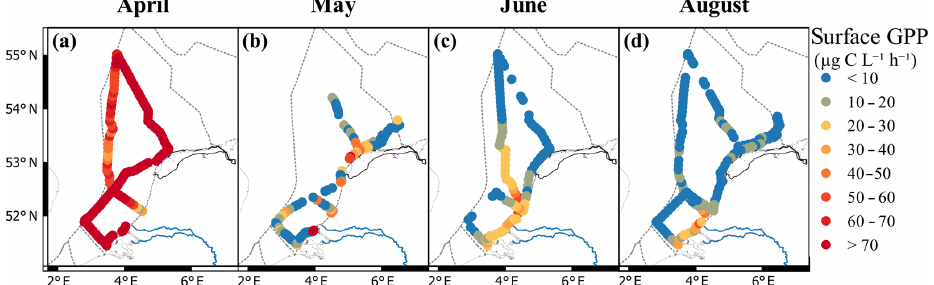
Figure 6. Gross primary productivity of the surface ( a–d ; µgCL − 1 h 1 ) per month ( a–d : April, May, June, and August). Colors represent rates; blue is low and red is high (see legend). Figure made with QGIS v2.14.2 using EEZ zone data from the Flanders Marine Institute